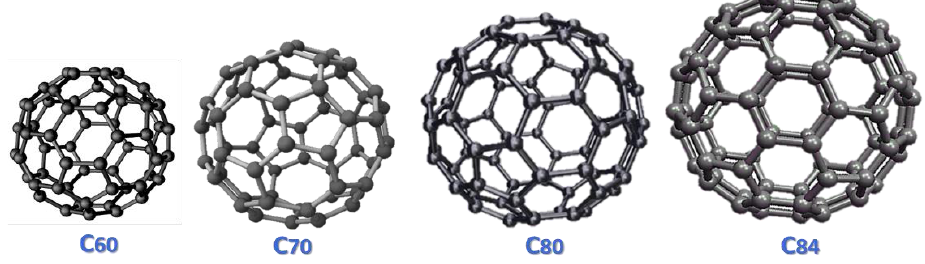
Figure 2. A few higher fullerene analogs.